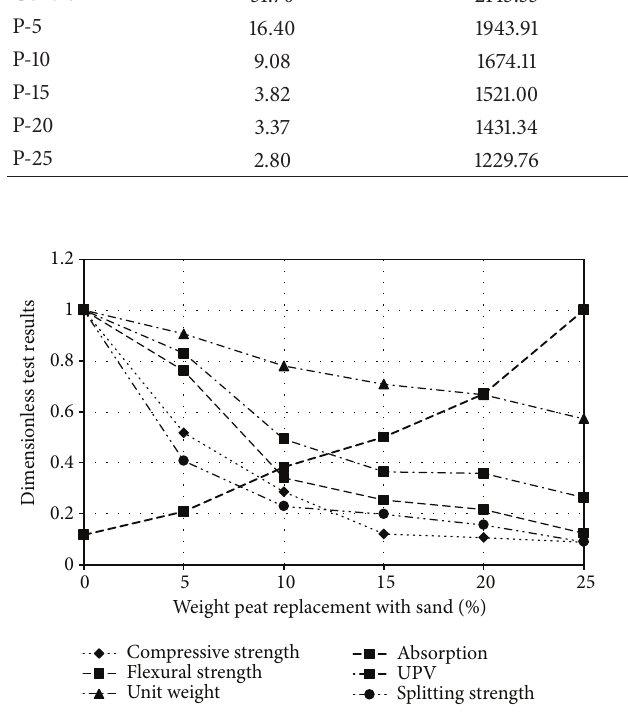
Figure 3: Dimensionless values for physicomechanical properties.